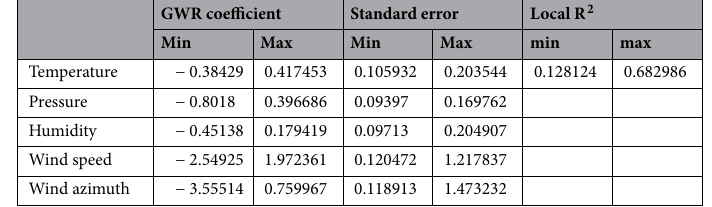
Table 7. Summary statistics for GWR on the 18th of